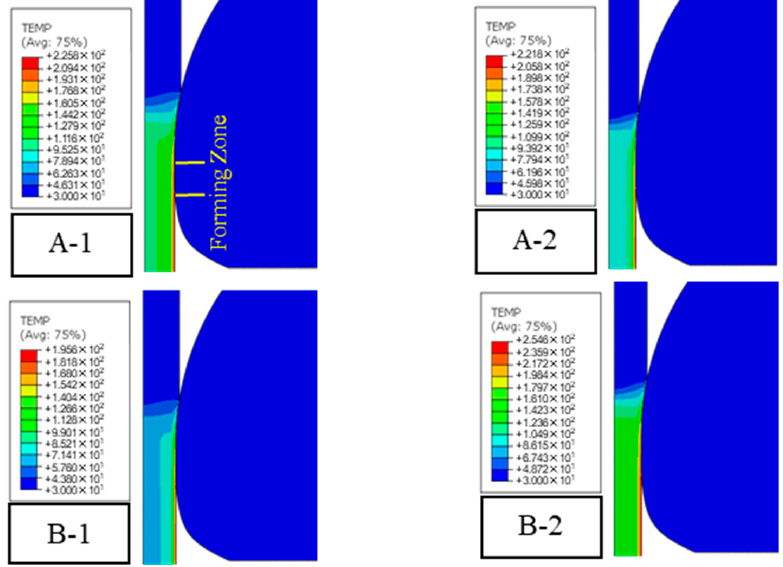
Figure 8. 2 D cloud diagrams of temperature distribution in wires. Figure 8. 2D cloud diagrams of temperature distribution in wires.